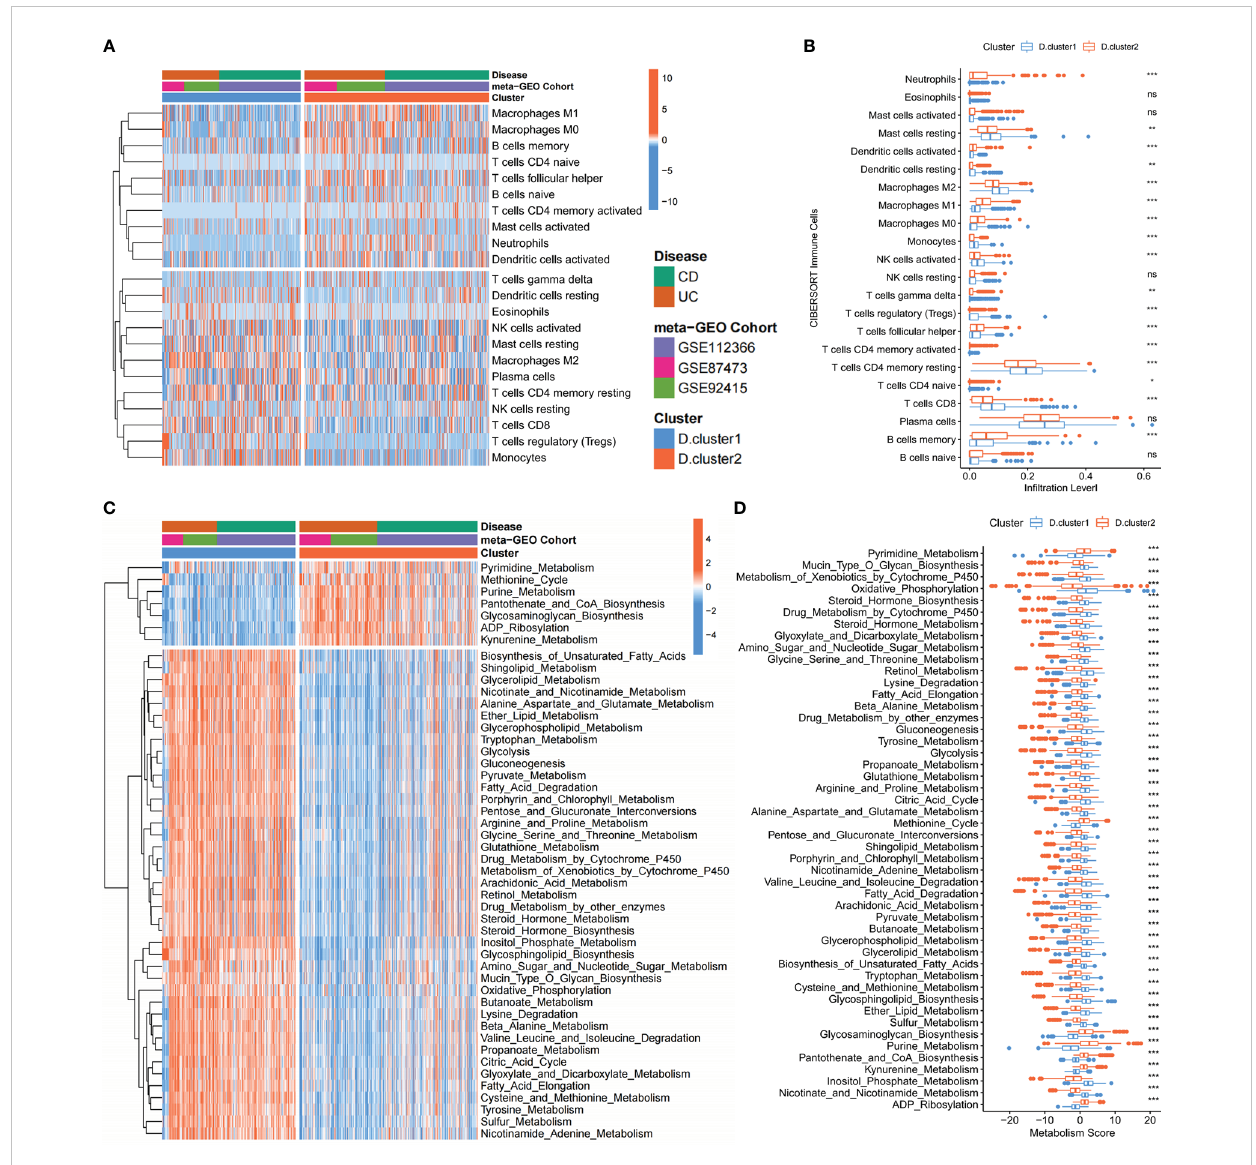
FIGURE 3 Depression-related molecular subtypes characterized by distinct immune and metabolism landscapes. (A, B) Heatmap and boxplot show the abundance of 22 immune in fi ltrating cells in two depression-related molecular subtypes. The upper and lower ends of the boxes represented the interquartile range of values. The lines in the boxes represented the median value, and the black dots showed outliers. (C, D) Heatmap and boxplot show the metabolic mapping in two depression-related molecular subtypes. The upper and lower ends of the boxes represented the interquartile range of values. The lines in the boxes represented the median value, and the black dots showed outliers. The asterisks represented the statistical p- value (ns P > 0.05; *P < 0.05; **P < 0.01; ***P <